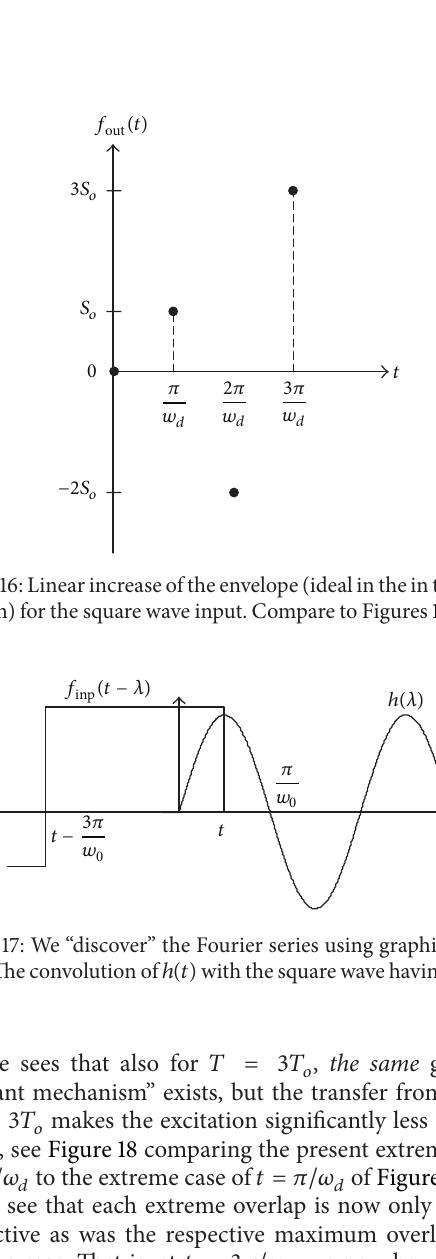
One sees that also for 𝑇 = 3𝑇 𝑜 , the same geometric “resonant mechanism” exists, but the transfer from 𝑇 = 𝑇 𝑜 to 𝑇 = 3𝑇 𝑜 makes the excitation significantly less intensive. Indeed, see Figure 18 comparing the present extreme case of 𝑡 = 𝜋/𝜔 𝑡 = 3𝜋/𝜔 𝑑 to the extreme case of 𝑑 of Figure